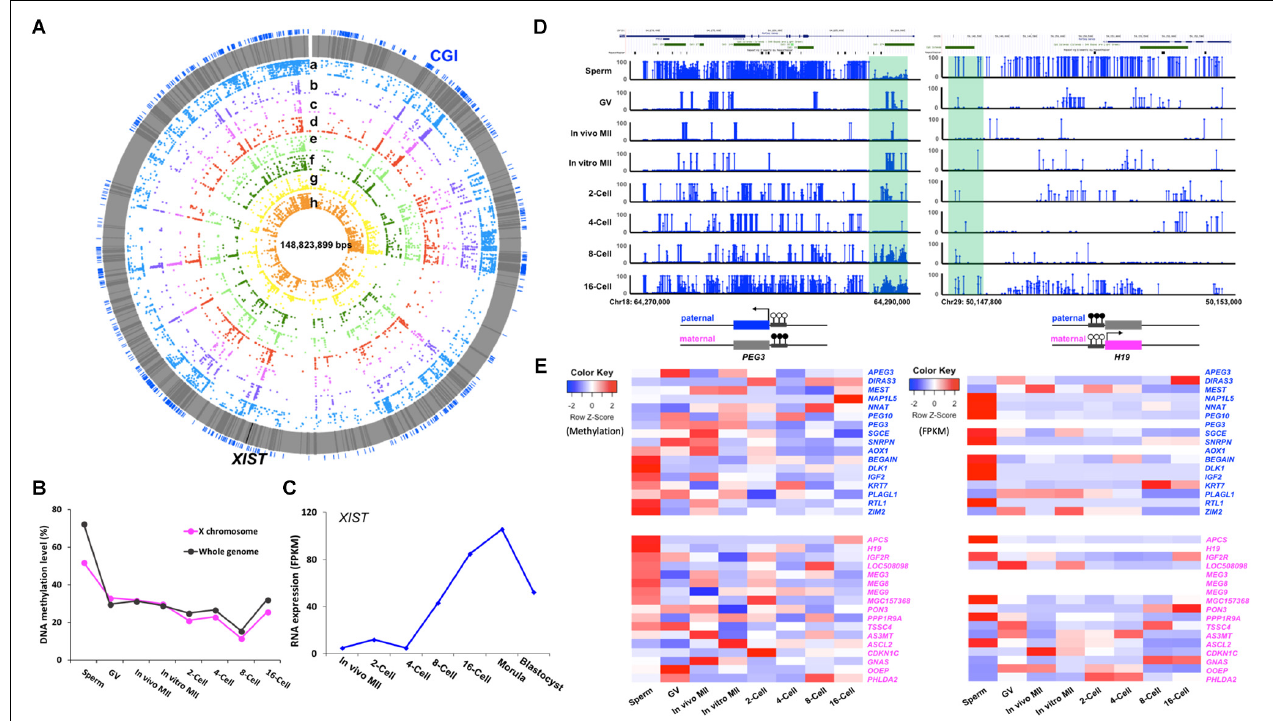
FIGURE 5 | Methylation of the X chromosome and imprinted genes in bovine gametes and pre-implantation embryos. Circos plot (A) visualization of the methylation dynamics of genomic region of the X chromosome. All genes are in gray lines, Xist gene is in black line. CGIs are in blue lines. (a) sperm, (b) GV, (c) in vivo MII, (d) in vitro MII, (e) 2-cell, (f) 4-cell, (g) 8-cell, (h) 16-cell. Line plot (B) showing the DNA methylation dynamics of the X chromosome followed the global pattern of methylation changes. Line chart (C) of fragment per kilobase million (FPKM) expressions levels of XIST (TPM) in bovine early embryos. Visualization of (D) imprinted control regions (ICR) of PEG3 and H19 . Heatmap of (E) of the methylation and expression levels (TPM) of 34 imprinted genes in pre-implantation embryos. GV, germinal vesicle oocytes; MII, matured oocytes. Blue text: paternally expressed genes, pink text: maternally expressed genes, Color key for heatmap: blue, hypomethylation and low expression, red, hypermethylation and high